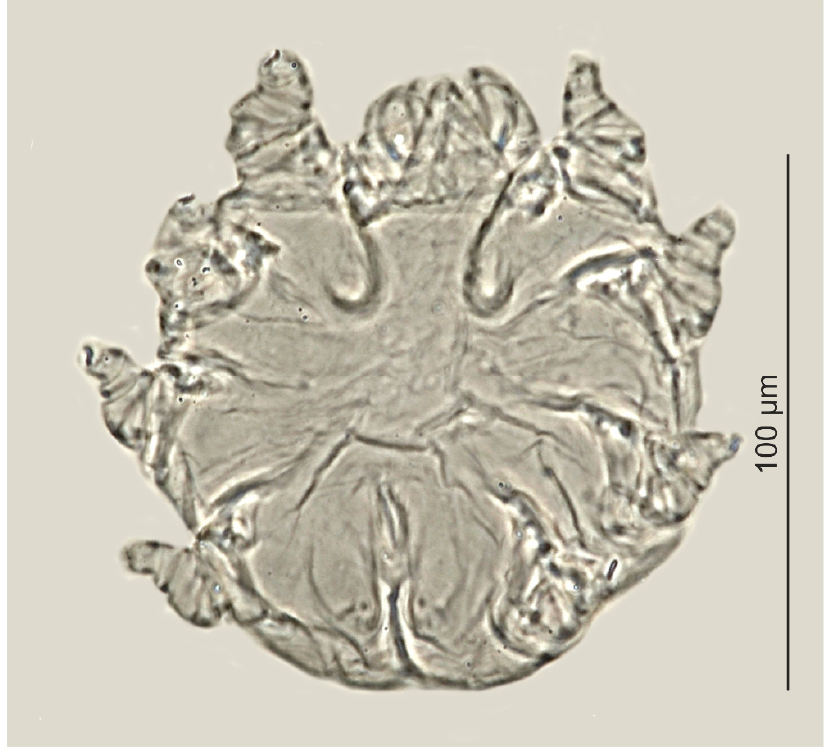
Figure 3. Psorergatoides kerivoluae , female.